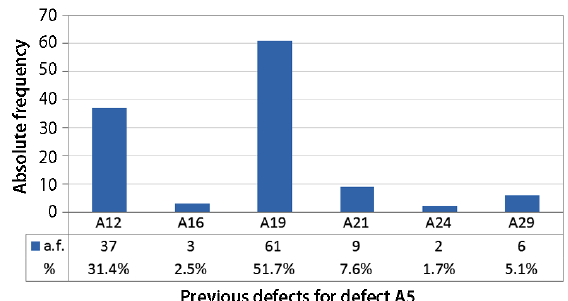
Fig. 18. Absolute frequency (a.f.) and percentage of previous defects for defect A5 – linear cracking